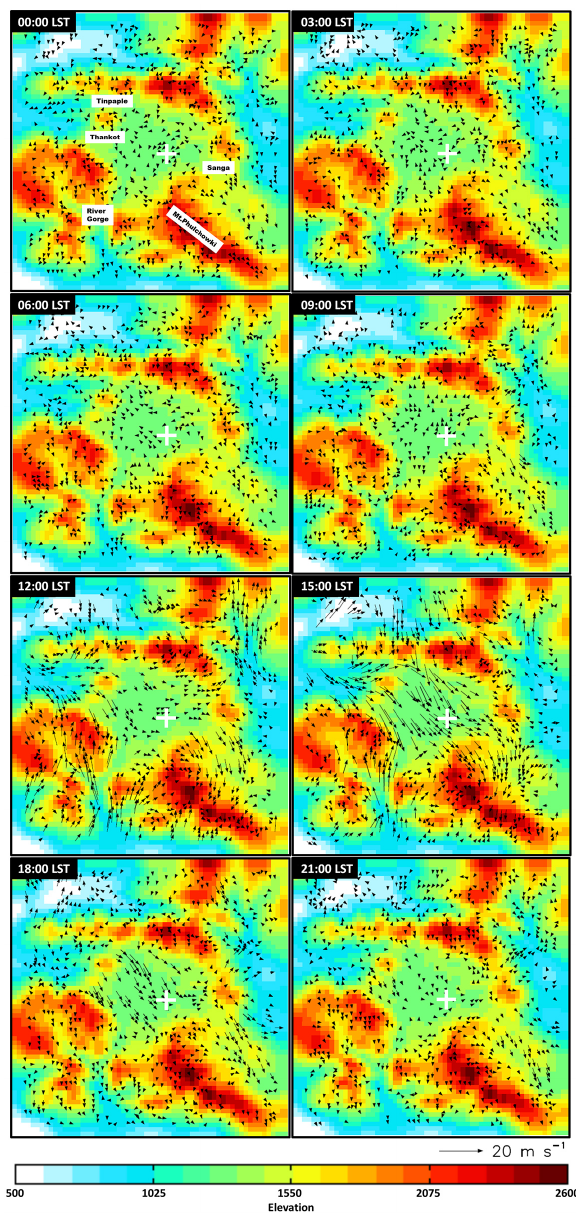
Figure 6. WRF simulation of near-surface winds for every three hours averaged during the study period in Kathmandu. The white crosshair is the location of the Bode site; the color shade represents the elevation